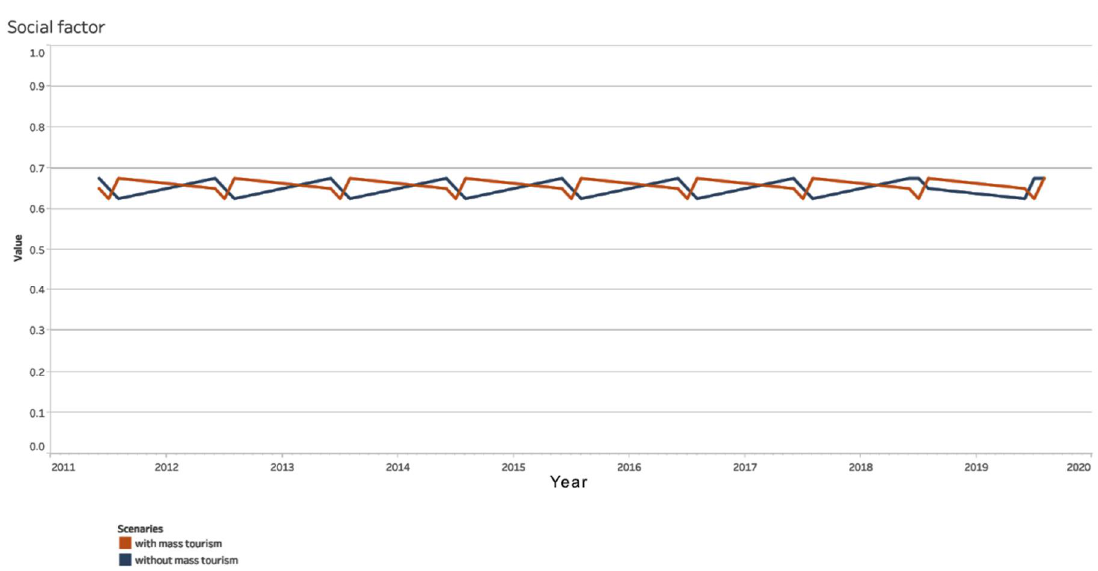
Figure 12. Economic factor forecast by 2050.